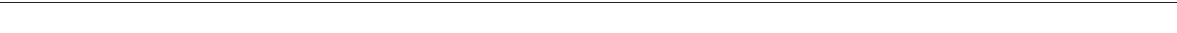
Fig. 1 Identi fi cation of phosphorylated proteins in guard cells mediated by phototropins using phosphoproteome analyses. a MS/MS spectrum of the phosphopeptide having the sequence RKpSLpSDGEDNVNNTR. b Changes in the phosphorylation levels of proteins having RKpSLpSDGEDNVNNTR in response to BL. Amounts of the phosphopeptides were calculated from the integrated peak values. The samples were obtained just before the BL, 0.5